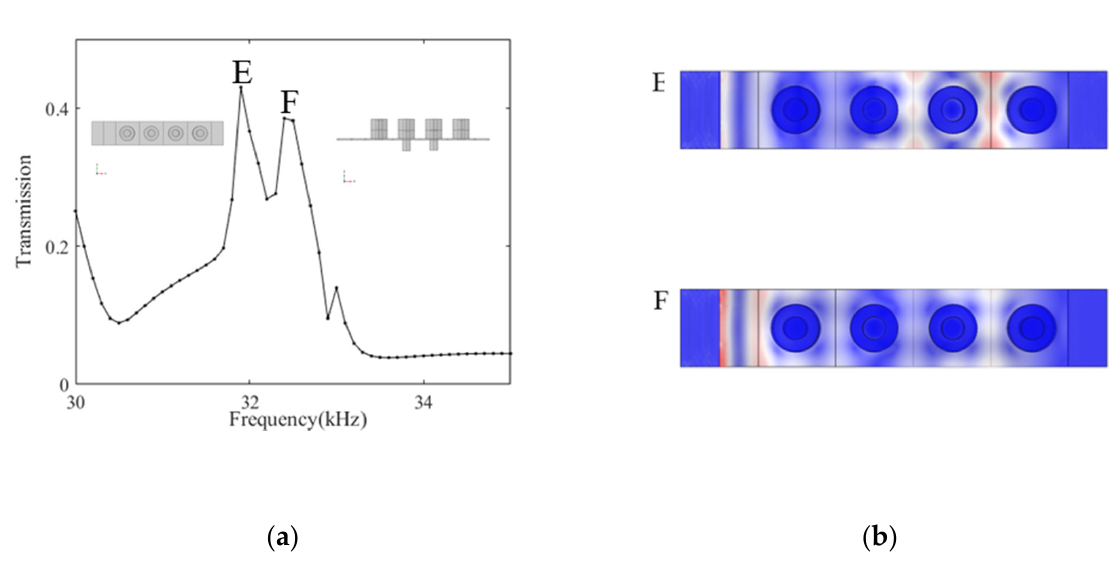
Figure 13. The schematic representation of the compact wavelength cavity multiplexer. ( a ) The transmission spectrum of the anti-symmetric Lamb wave when FR (E) = 46.67% and FR(F) = 50% in the waveguide; ( b ) displacement field distribution at two narrowband frequencies, E, and F.